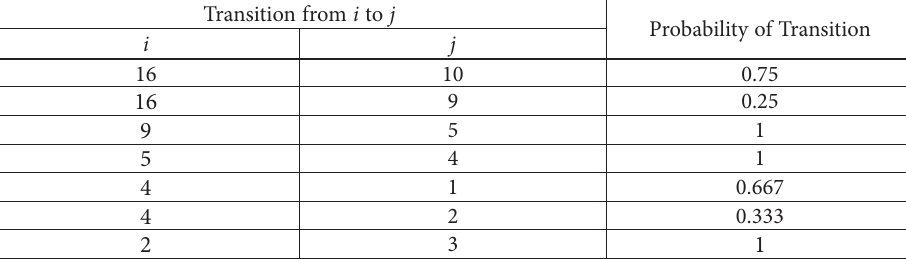
Table 7. Probabilities of transitions – partial ignorance